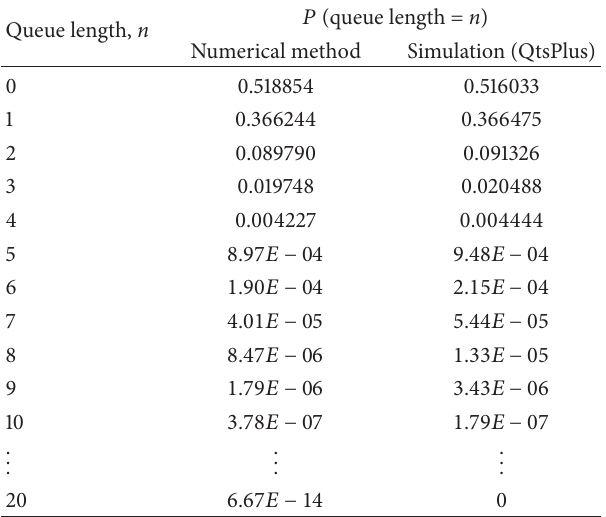
Table 1: Comparison of stationary queue length distribution com- puted from the proposed numerical method, and that obtained from thesoftware“QtsPlus”[( 𝜅 1 , 𝜃 1 )=(1.5,2),( 𝜅 2 , 𝜃 2 )=(3.1,2), Δ𝑡